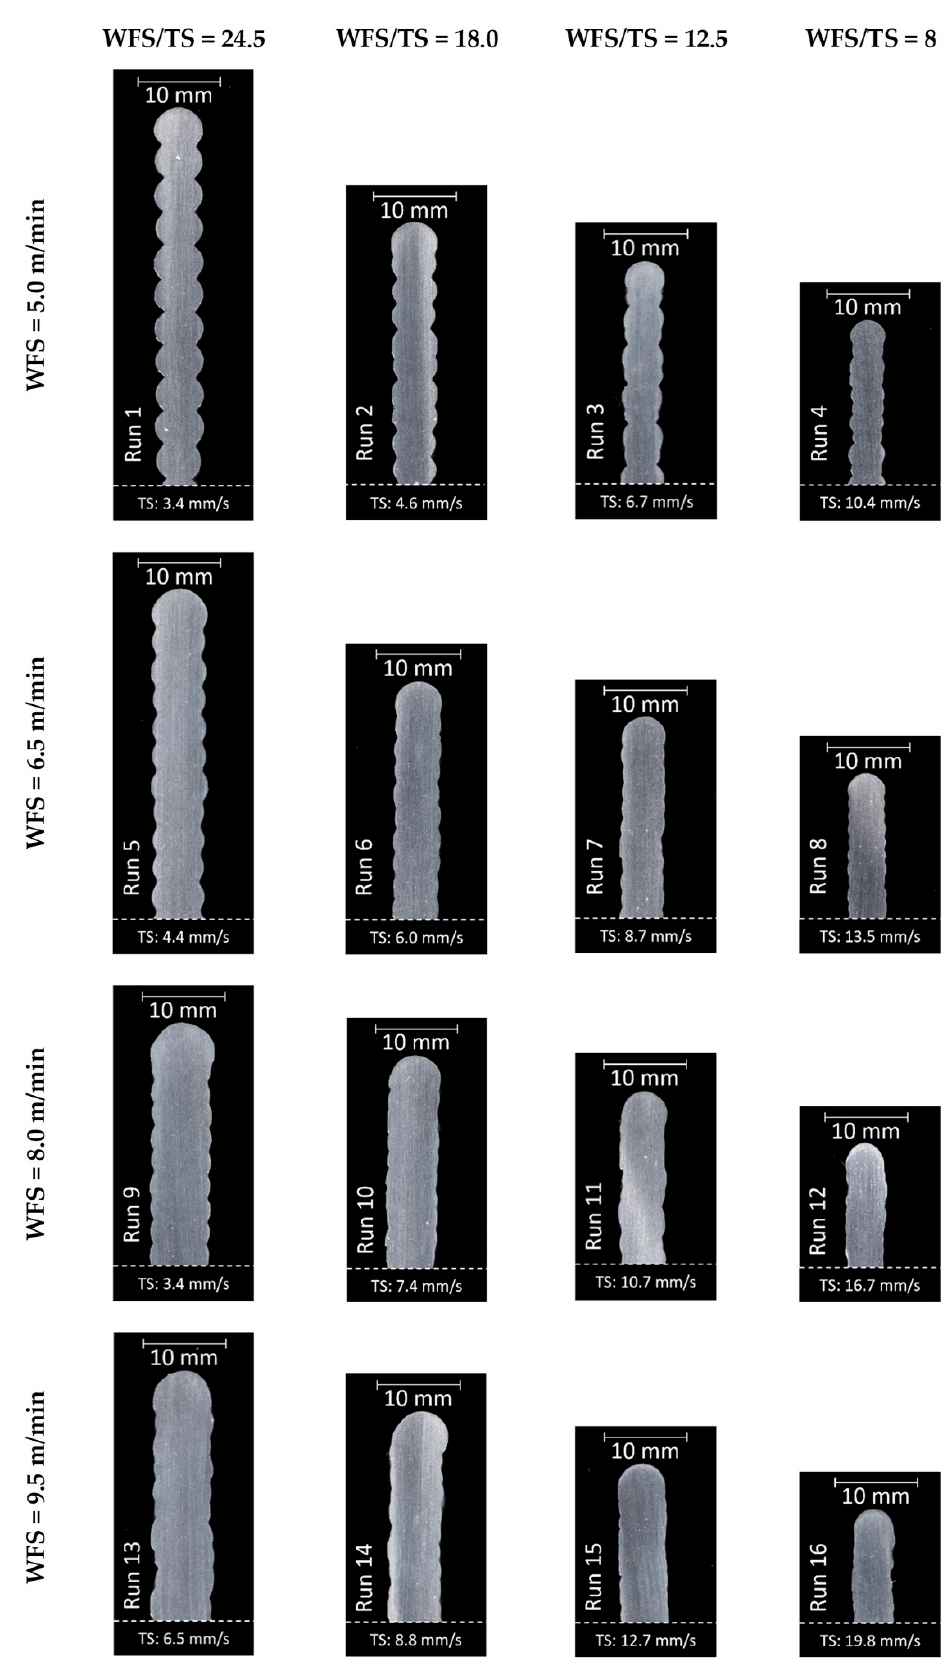
Figure 9. Atlas of the typical cross-sections of the preforms in terms of WFS values and WFS/TS ratios.